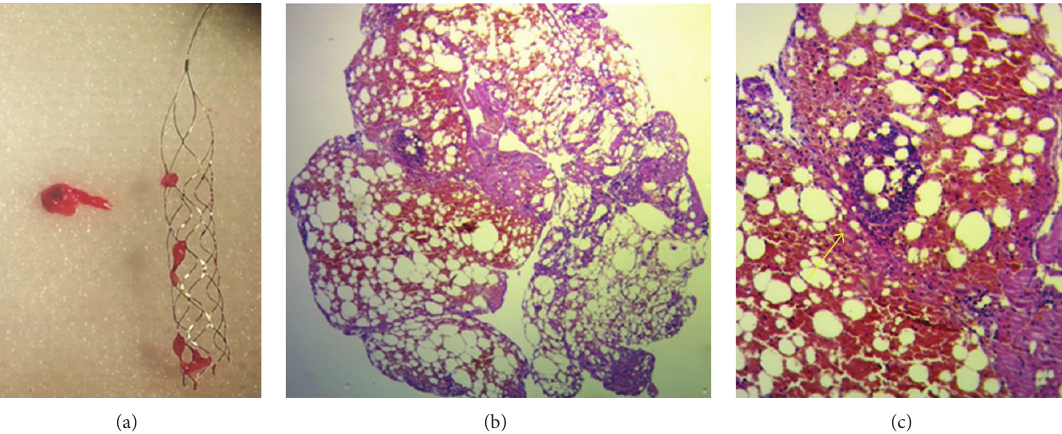
Figure 3: A macroscopic photograph of the fat emboli (a). Histological simple photograph with hematoxylin and eosin at 4x (b) and 10x (c) where an adipose fragment of bone morrow interspersed with fibrin is seen. In addition image (c) shows a bone marrow lymphoid accumulation